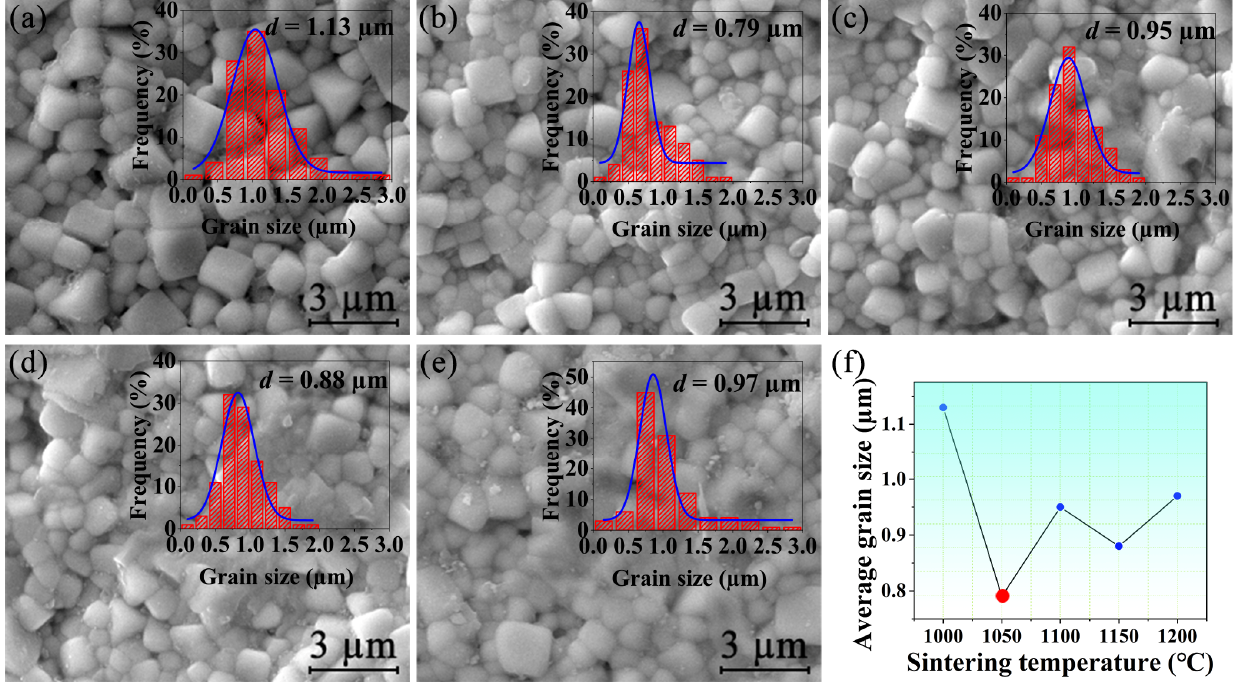
Figure 3. SEM images of the NBT-BT-NN ceramics with sintering temperature of ( a ) 1000 °C, ( b ) 1050 °C, ( c ) 1100 °C, ( d ) 1150 °C, ( e ) 1200 °C. The insets in ( a – e ) are the corresponding grain size distribution. ( f ) Variation of average grain size of ceramics at different sintering temperatures.